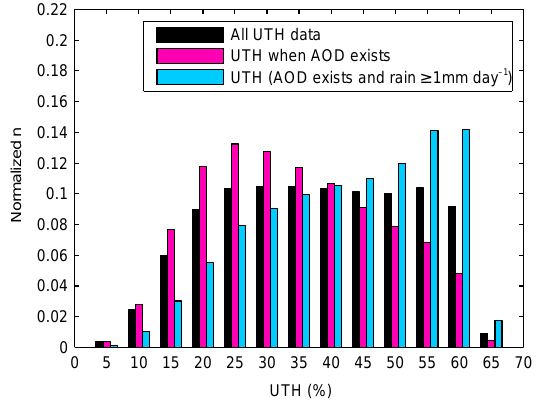
Figure 3. The relation between cirrus fraction and AOD. Histogram of MODIS AOD for all the data and segregated for small ( < 0.2) or large ( > 0.5) cirrus fraction (CF) in the same 1 ◦ × 1 ◦ grid east of China in June, July and August in 2007–2013. For visual clarity, the AOD data considered here are restricted to values smaller than 0.6. The difference between these two distributions indicates that cirrus may contaminate the AOD data retrieval. Therefore, we removed the cirrus dependence from the AOD data (as explained in Fig. 4) to ensure that the relationship between AOD and UTH is not due to data contamination.